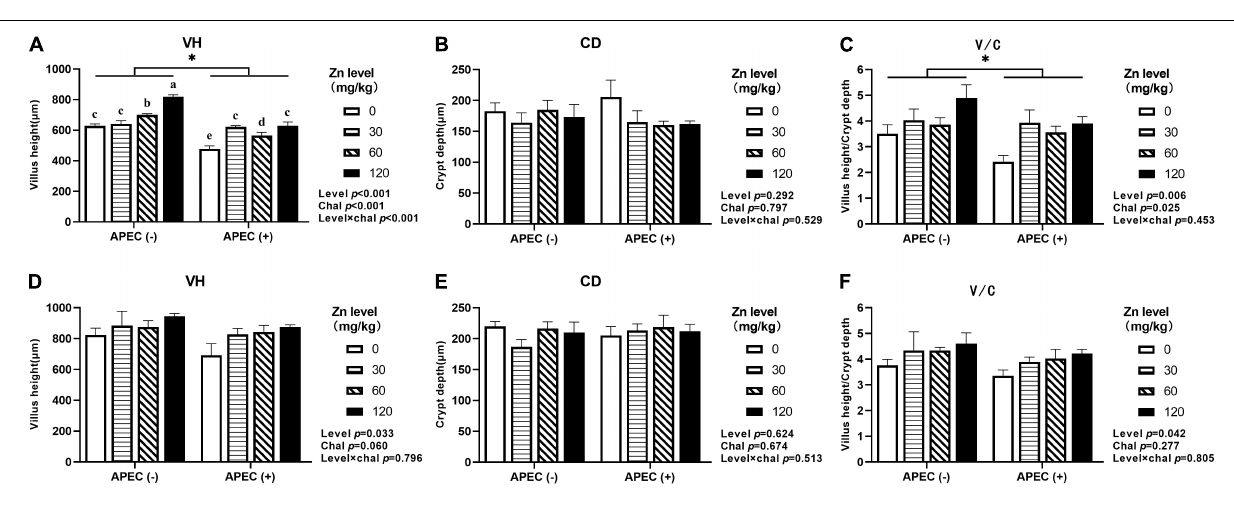
FIGURE 3 | Effect of dietary Zn–Met levels on the jejunum VH (A) , CD (B) , and V/C (C) of meat duck challenged with APEC O78 (2 DPI). Effect of dietary Zn–Met levels on the jejunum VH (D) , CD (E) , and V/C (F) of meat duck challenged with APEC O78 (8 DPI). Bars with different letters are statistically significant ( P < 0.05) and * means significant ( P < 0.05) between APEC ( − ) and APEC ( + ). Results are expressed as mean ± SEM ( n =